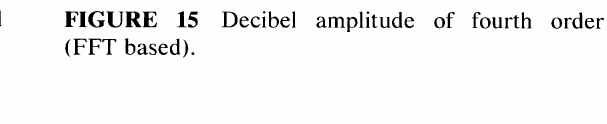
FIGURE 13 RPM of vehicle as function of elapsed time.